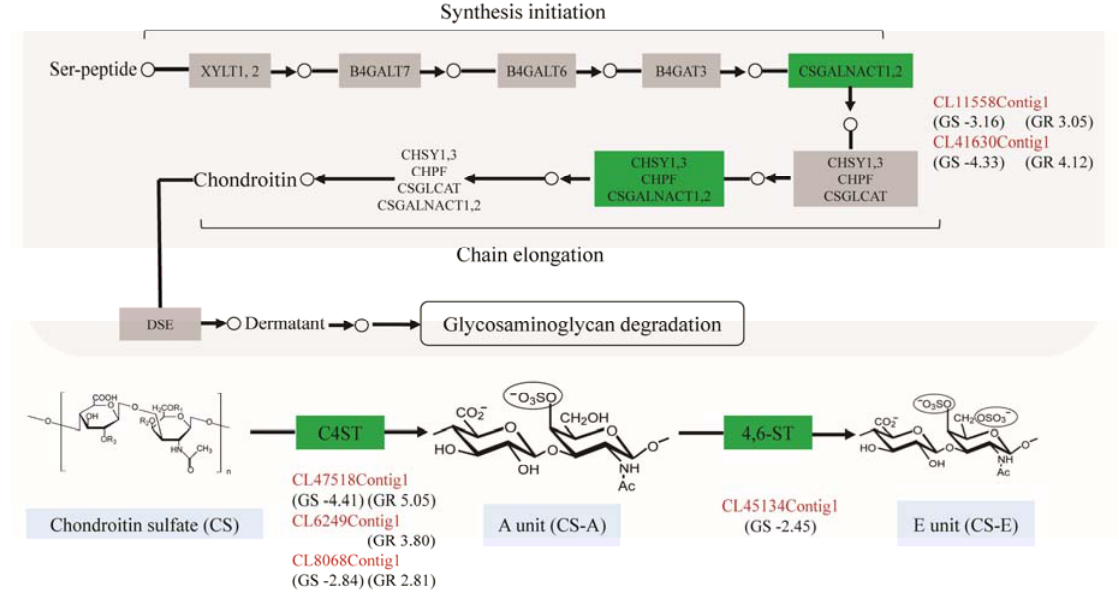
Figure 3. The pathway of glycosaminoglycan biosynthesis in P. clarkii and the related genes up ‐ or downregulated in GS and GR. The unigene identity was colored in red; the green boxes represent the upregulated or downregulated gene(s); the numbers in the brackets indicate log2 (fold